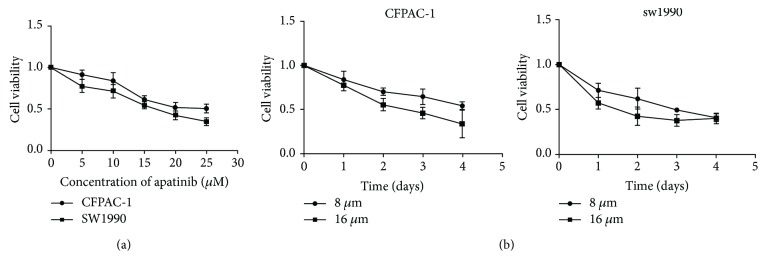
Apatinib inhibited cell proliferation in a concentration- and time-dependent manner. (a) Cell viability assays of CFPAC-1 and SW1990 cells treated with low-to-high concentrations of apatinib for 48 h. (b) The CFPAC-1 and SW1990 cells were treated with apatinib (8 μM or 16 μM) for different time intervals. The inhibitory activity was expressed as an inhibition rate. All experiments were performed in triplicate. The results represent mean ± standard deviation; n = 4, P < 0.05.